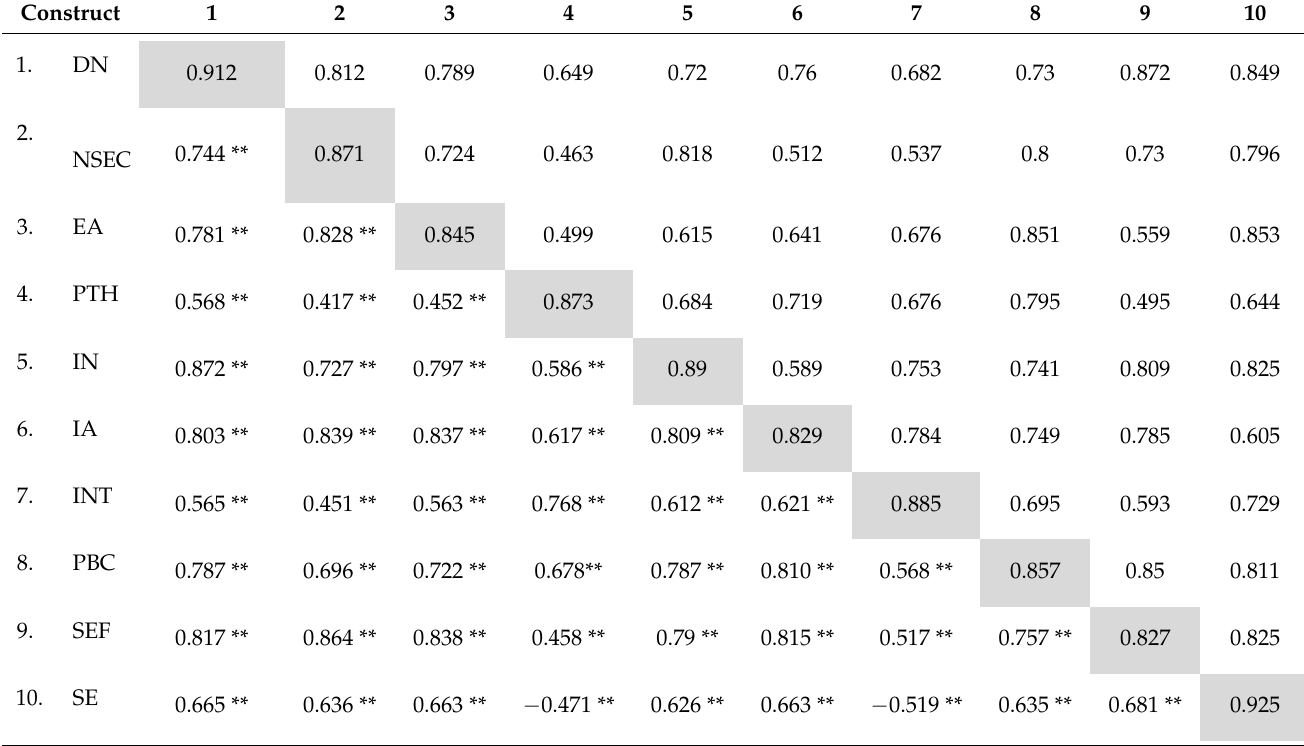
Table 2. Fornell–Lacker criterion and Heterotrait–Monotrait (HTMT) ratio